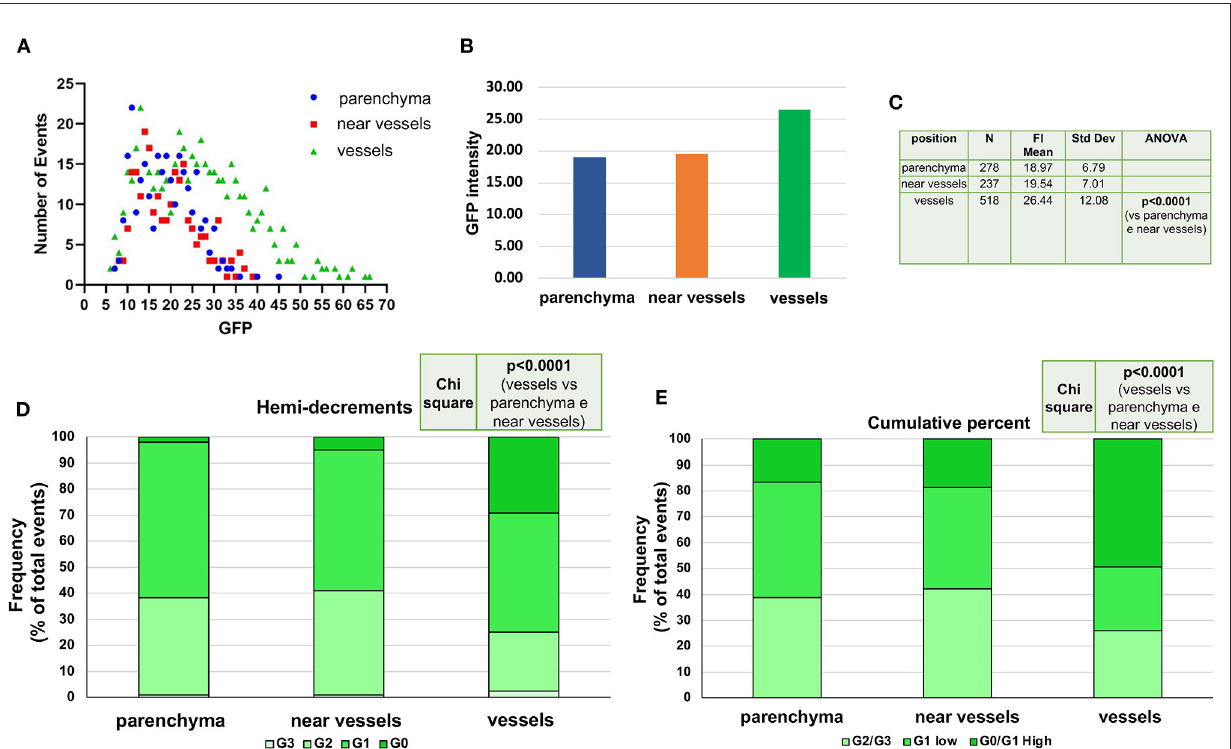
FIGURE6 The cells expressing the highest levels of GFP are localized in proximity of the vessels. (A) Distribution of the levels of GFP expressed by single cells (each symbol a different cell) according to their localization. GFP positive cells were divided into cells surrounding vessels, in close proximity (within 20 ?m) of a vessel or within the BM parenchyma, as indicated. The cell localization was determined by the Image J program and by the control software of acquisition ZenBlue. (B) Overall GFP intensity expressed by the cells according to their location. (C) Number and GFP content [Mean ( + /-SD)] of the single GFP + cells analyzed for each localization. The p value was analyzed by ANOVA. (D, E) Distribution of single cells expressing different levels of GFP fluorescence intensity divided by either the hemi-decrement or the cumulative percent criteria (the same criteria as in Figure 3). In both analyses, Chi-Square test shows statistically significant difference in the localization of the GFP positive cells, with the cells expressing the highest levels localized around